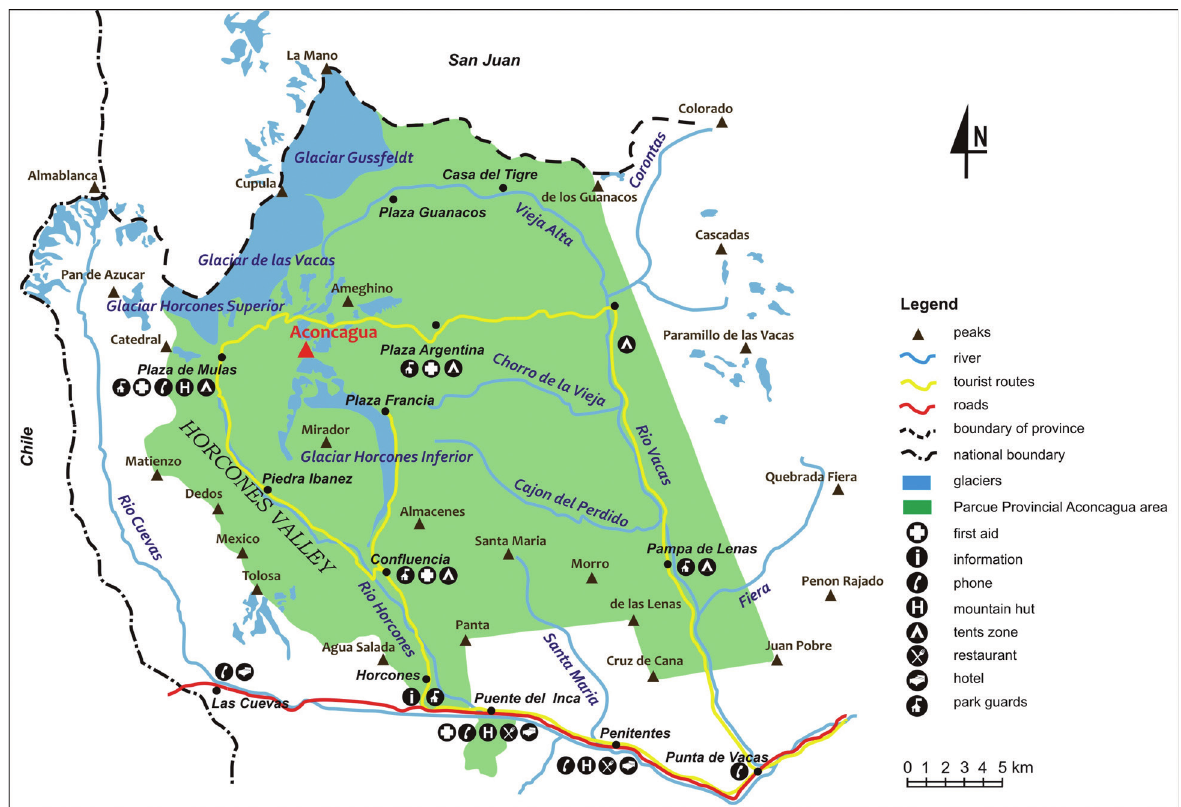
Fig. 1. Location of Aconcagua summit against the Aconcagua Provincial Park. Source: Guide of Parque Provincial Aconcagua, Localización de campamentos, rutas y